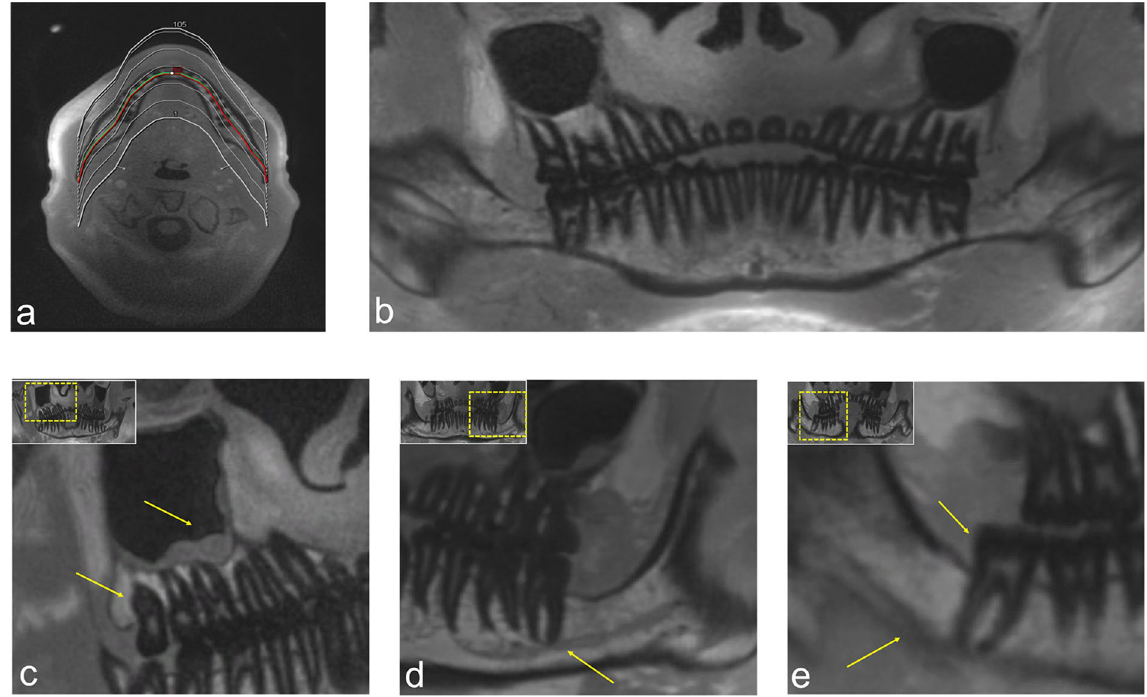
Figure 4. OPG (orthopantomogram) - like MRI reconstructions (MR-OPGs) from a 3D ultrashort echo time (UTE) prototype sequence for bone and teeth imaging. ( a ) The planning of the orthopantomogram-like MR images. ( b ) Overview image of a UTE MR-OPG. ( c ) Visualization of the positional relationship of the maxillary third molar in the first quadrant and the maxillary sinus, with a retention cyst. ( d ) Visualization of the course of the hypointense inferior alveolar nerve (IAN) within the inferior alveolar canal through the mandible. ( e ) Shows the positional relationship between the mandibular third molar and the IAN in UTE